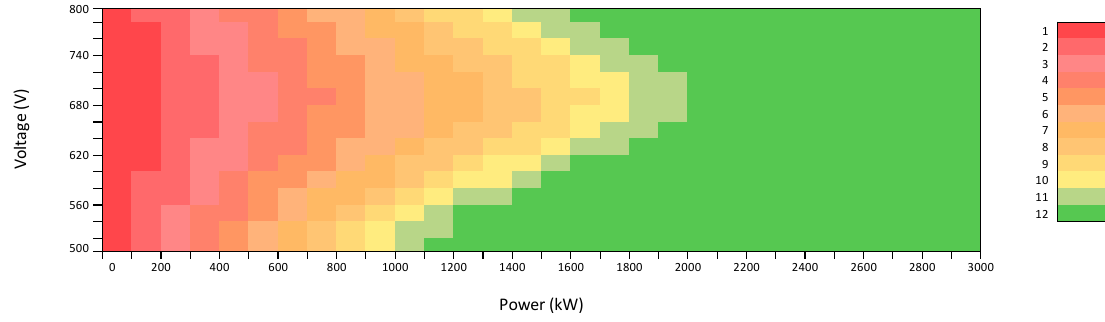
Figure 10. Number of inverters in operation depending on the power generation and the maximum power point tracking (MPPT) voltage.